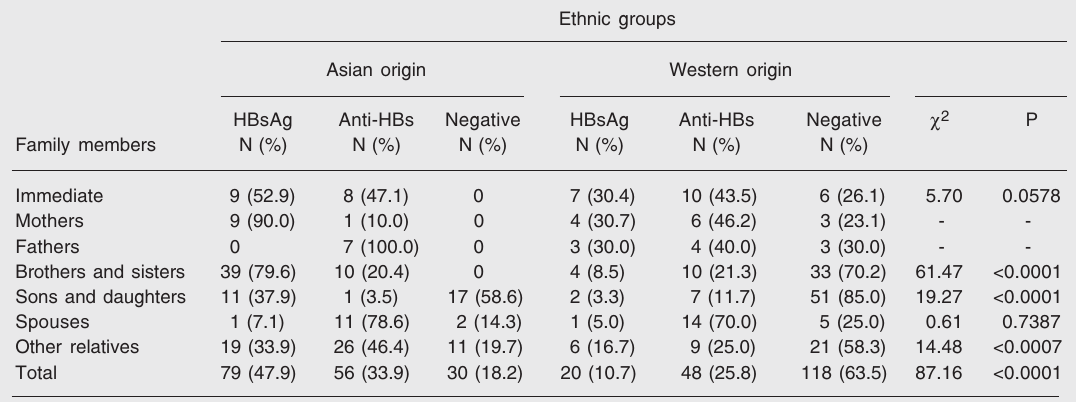
Table 1. Frequency of HBsAg and anti-HBs antibodies in family members of probands with HBsAg-seropositive chronic liver